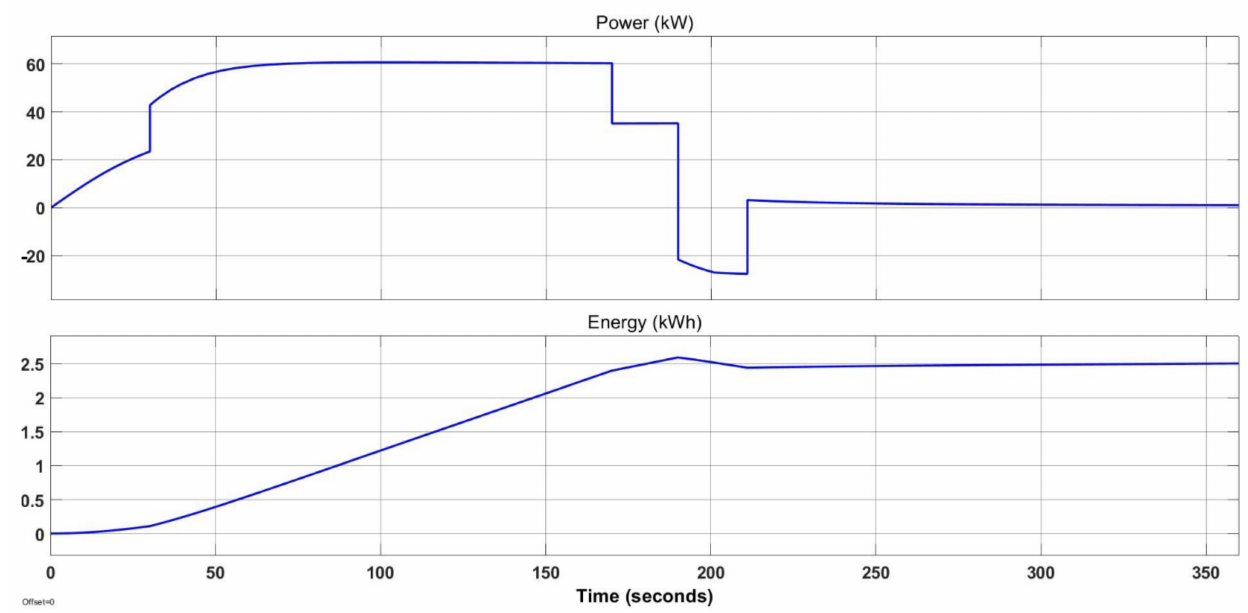
Figure 10. Power demand and energy consumption of electric PZL-101 Gawron—tow at height 300 m.